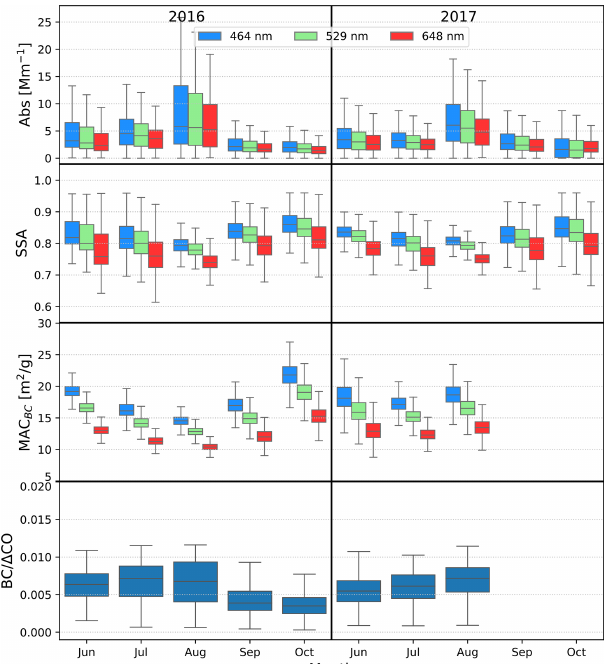
Figure 1. Monthly percentiles (10%, 25%, 50%, 75%, and 90%) of aerosol absorption coefficient, SSA, MAC BC , and BC /(cid:49) CO as box–whisker plots spanning the fire season in 2016 and 2017. The light blue, green and red colours of absorption, SSA, and MAC BC indicate observations at wavelengths of 464, 529, and 648nm, re-